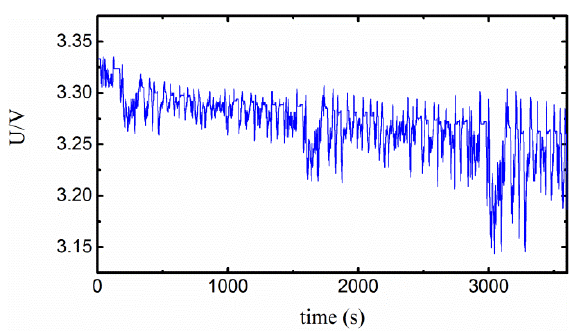
Figure 7. Terminal voltage of battery with parameter slow ‐ varying fault.